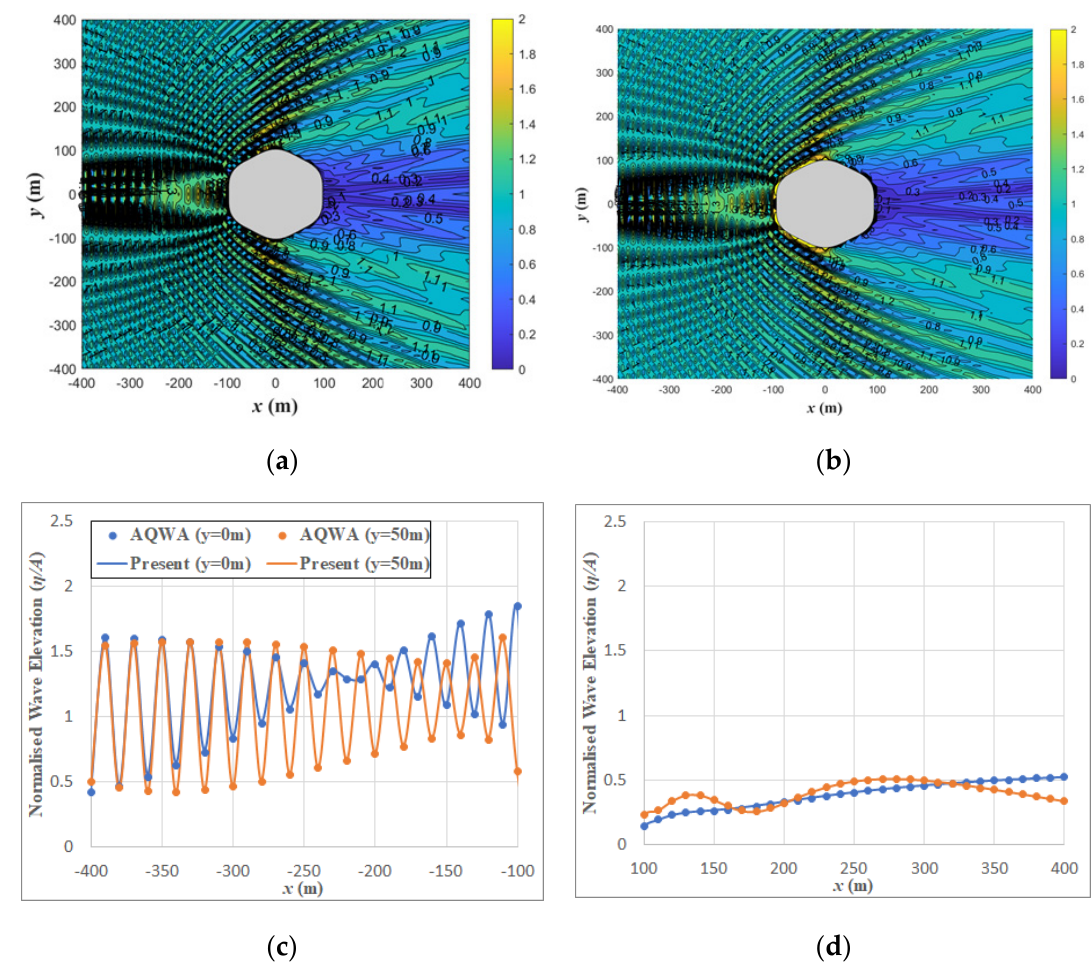
Figure 5. Comparison of normalised wave elevations obtained from AQWA and semi-analytical approach (for T = 5 s): ( a ) wave field from semi-analytical approach; ( b ) wave field from AQWA; ( c ) wave profiles in the sea side; and ( d ) wave profiles in the lee side. Table 2. Comparison of computational times of different methods. (Note: values in parentheses denote the truncated numbers of M , N , N r , and Q ; NA, not applicable; and ∆ denotes the maximum mesh